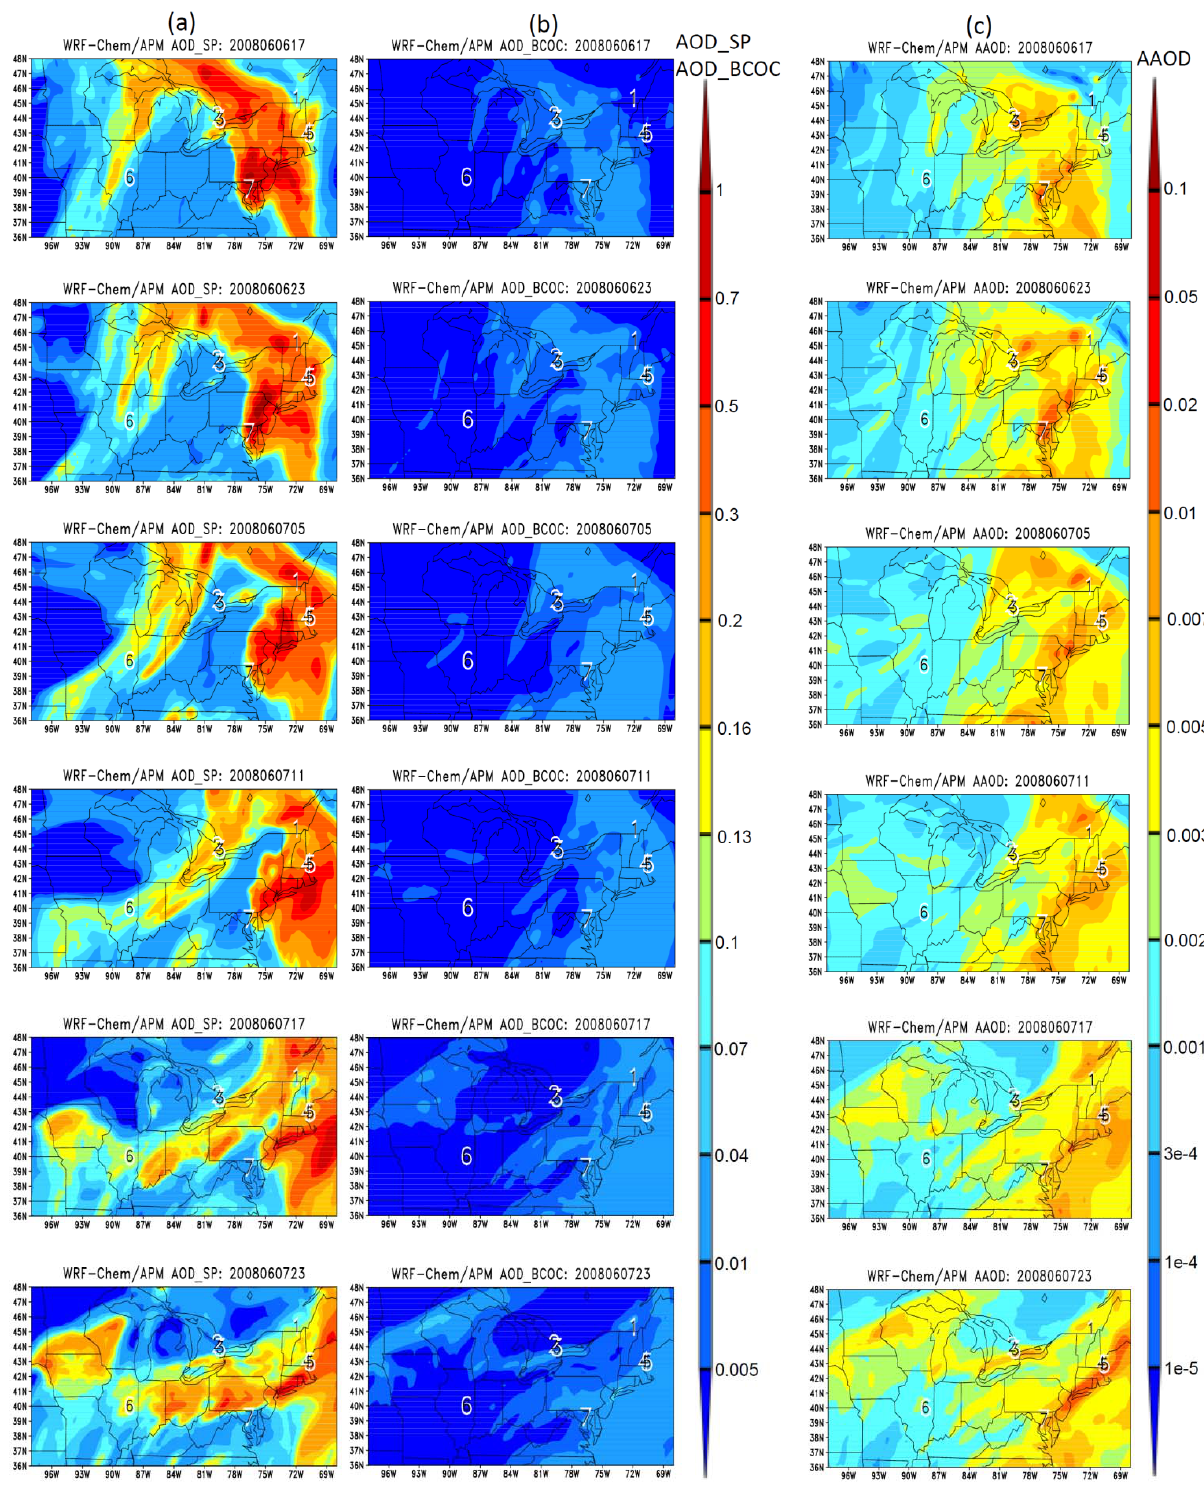
Fig. 10. Same as Fig. 9 but for, AOD associated with (a) SP and (b) coated BC and POC (BCOC), and (c) AAOD.